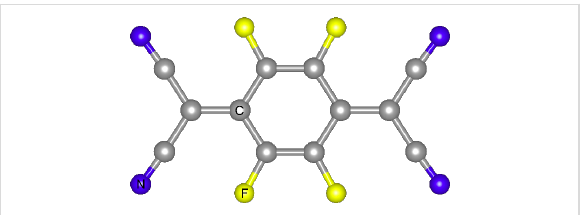
Figure 6: Molecular structure of a) pyrenetetrasulfonic acid (TPA) and b) tetracyanoethylene